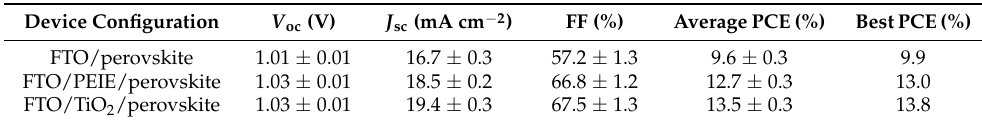
Table 1. Solar parameters (extracted from 16 individual devices) of the PSCs fabricated on bare FTO, FTO/PEIE and FTO/TiO 2 .